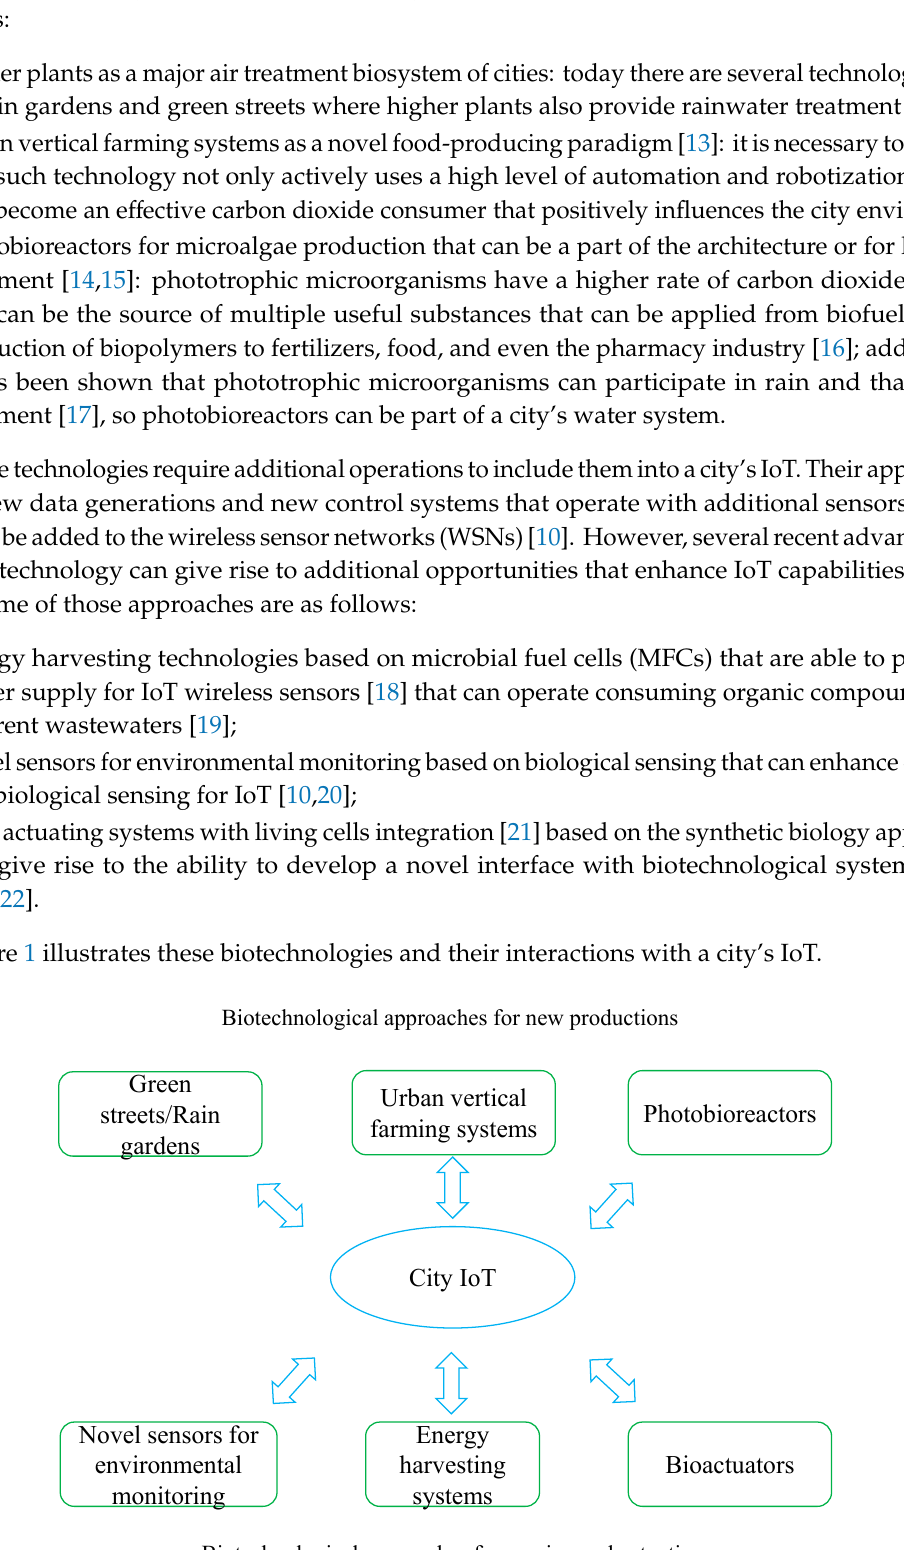
Figure 1. Interactions between several biotechnologies and a city’s Internet of Things